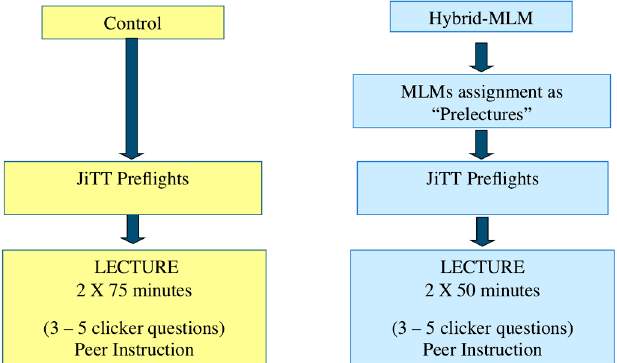
FIG. 2 (color online). A schematic representation of the con- trolled study design. The students in the MLM group viewed an average of two MLMs per week, a total of 17 during the